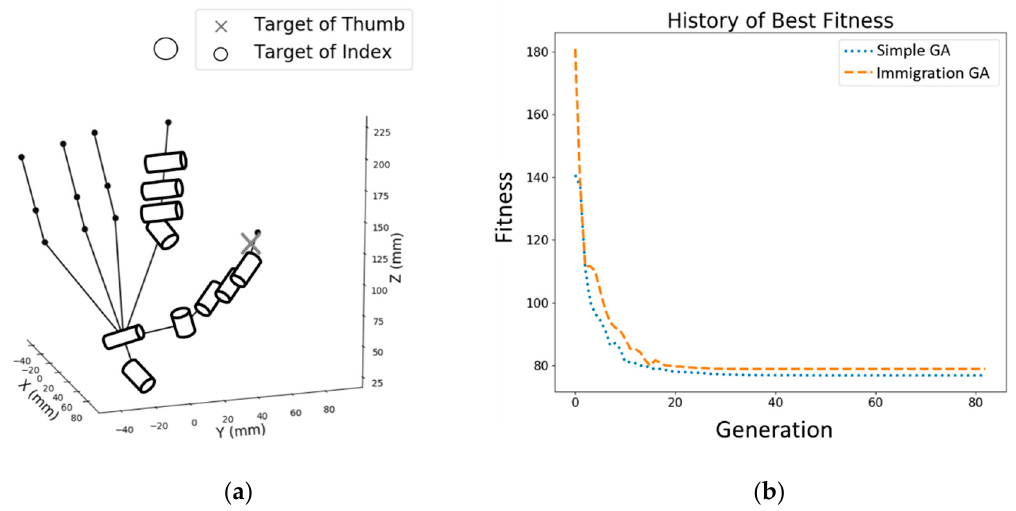
Figure 6. ( a ) Schematic illustration showing the solution resulting from an appropriate motion command and ( b ) the cor- responding fitness performance of the illustrated case #1.